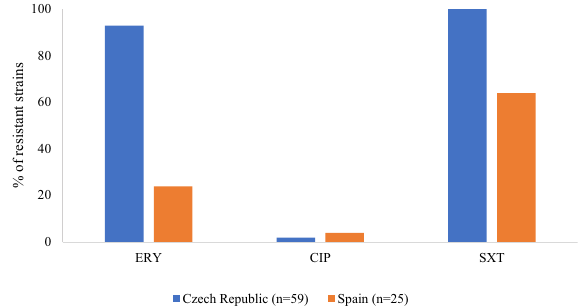
Figure 3. The occurrence of resistant clinical isolates of cluster C in Czech Republic and Spain. Comparison of AST results preformed in this study with the ones reported in a recent study by 14 . ERY - erythromycin, CIP - ciprofloxacin, SXT -